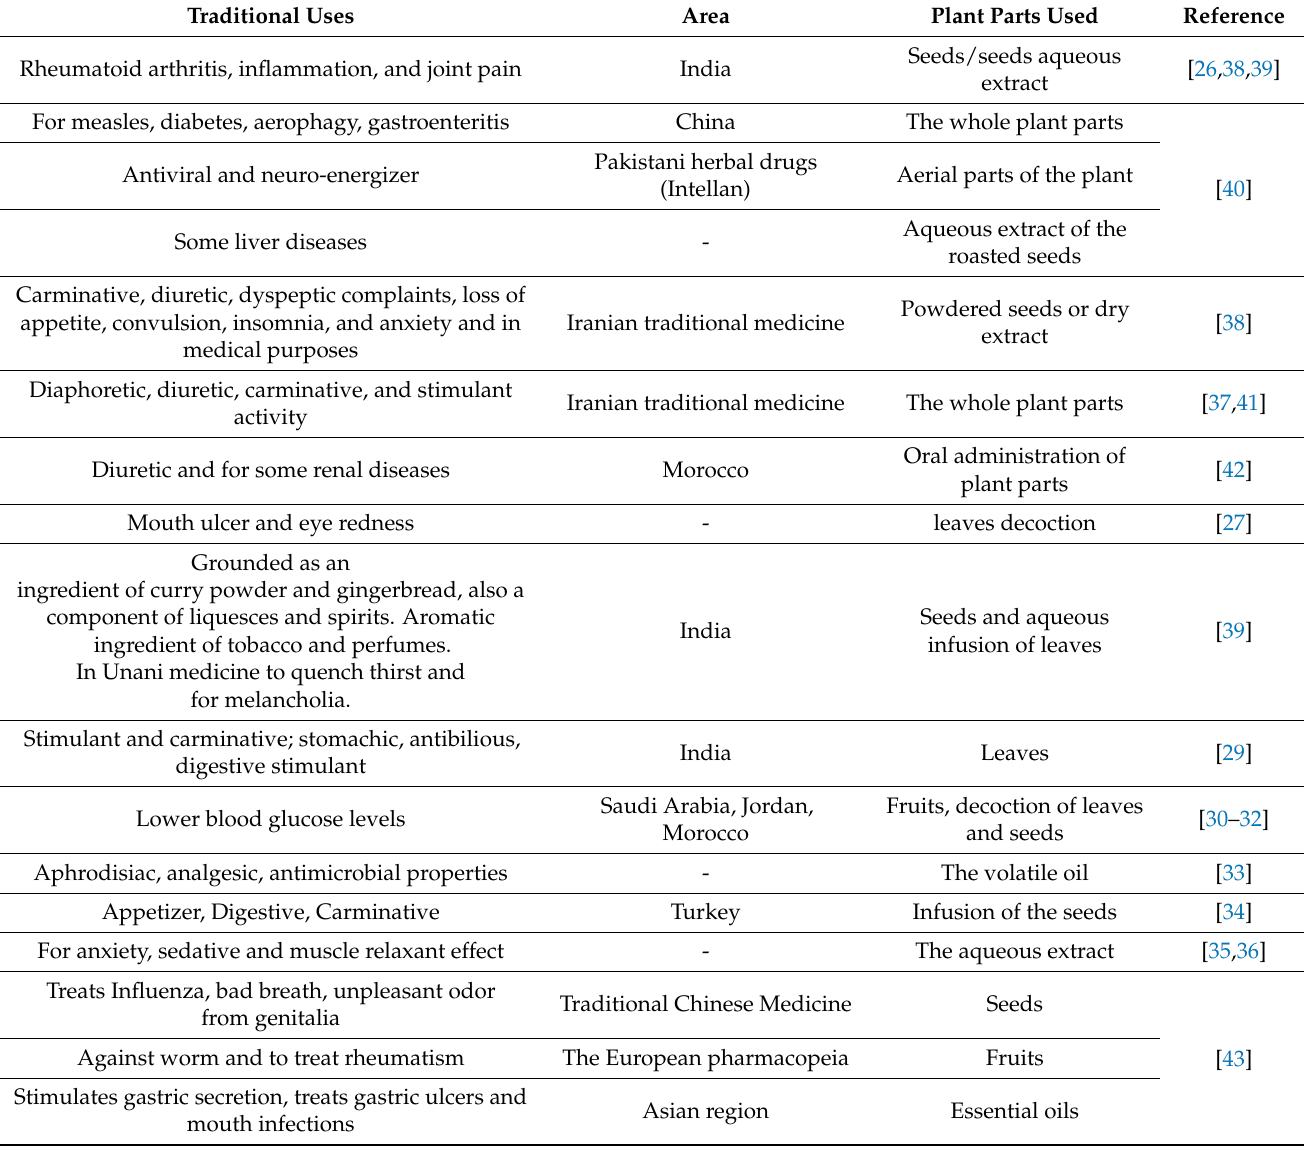
Table 2. Traditional uses of C. sativum in different